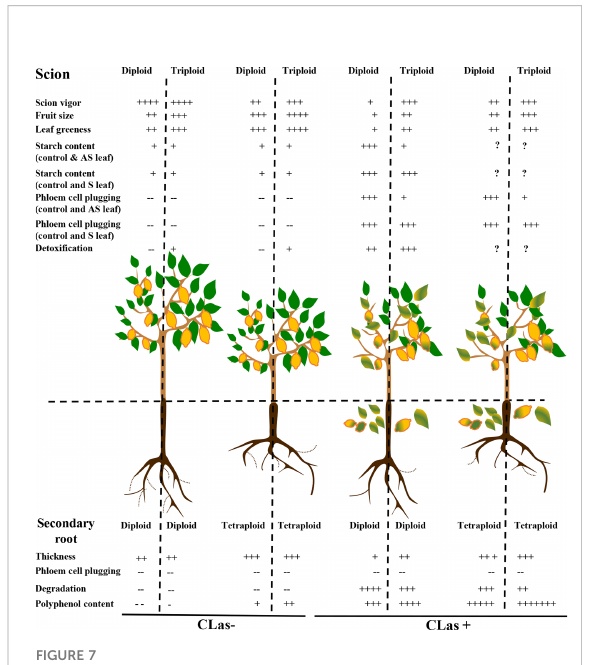
FIGURE 7 Impact of polyploidy at the rootstock and scion levels regarding different phenotypic traits modi fi ed by HLB. Scion/rootstock associations are evaluated in control (CLas-) and HLB infected trees (CLas+). AS leaf means asymptomatic leaf, and S leaf means symptomatic leaf. Data in the 2x and 3x scions grafted onto 2x rootstock are extracted from (Sivager et al.,